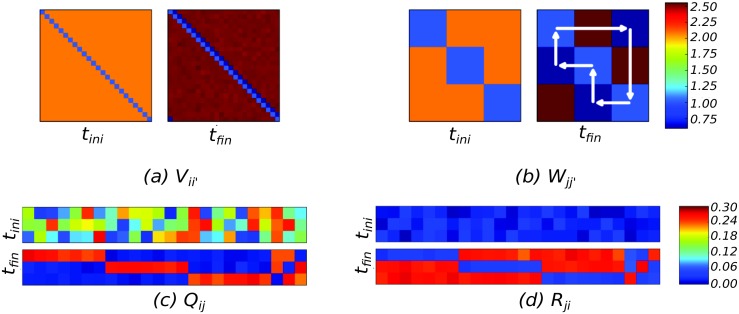
Synaptic weights before and after learning.(a, b) Initially (t
ini), the recurrent weight matrices implement all-to-all symmetric inhibition, leading to WTA. After learning t
fin the matrices acquire an asymmetric component, leading to WLC. Superimposed white arrows in (b) indicate the resulting order of the recalled states. (c, d) The weights in the matrices Q
ij and R
ji learn which EM belongs to which chunk. The last three columns correspond to the elements that activate during chunk transitions.